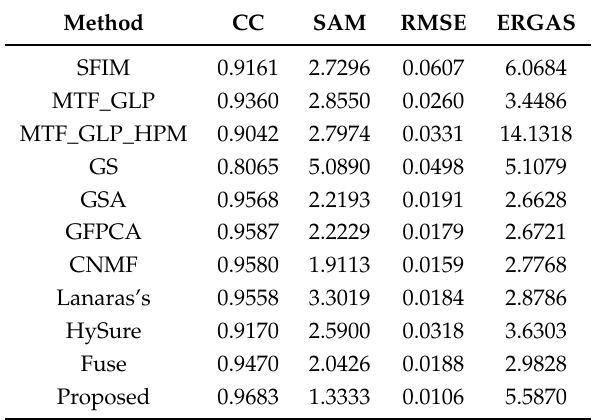
Table 3. Objective performance of eleven methods on the Salinas Scene data